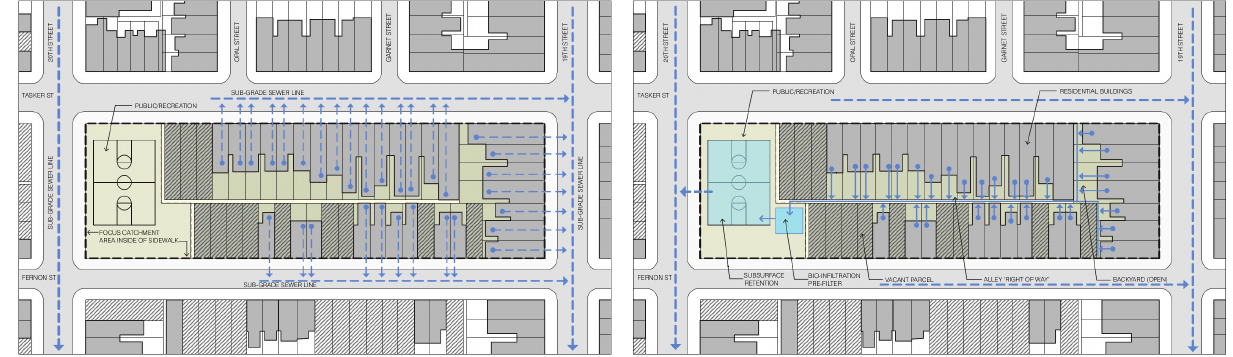
Figure 6. Model 2—Plan view of catchment area and existing drainage (left), and proposed GI (right).